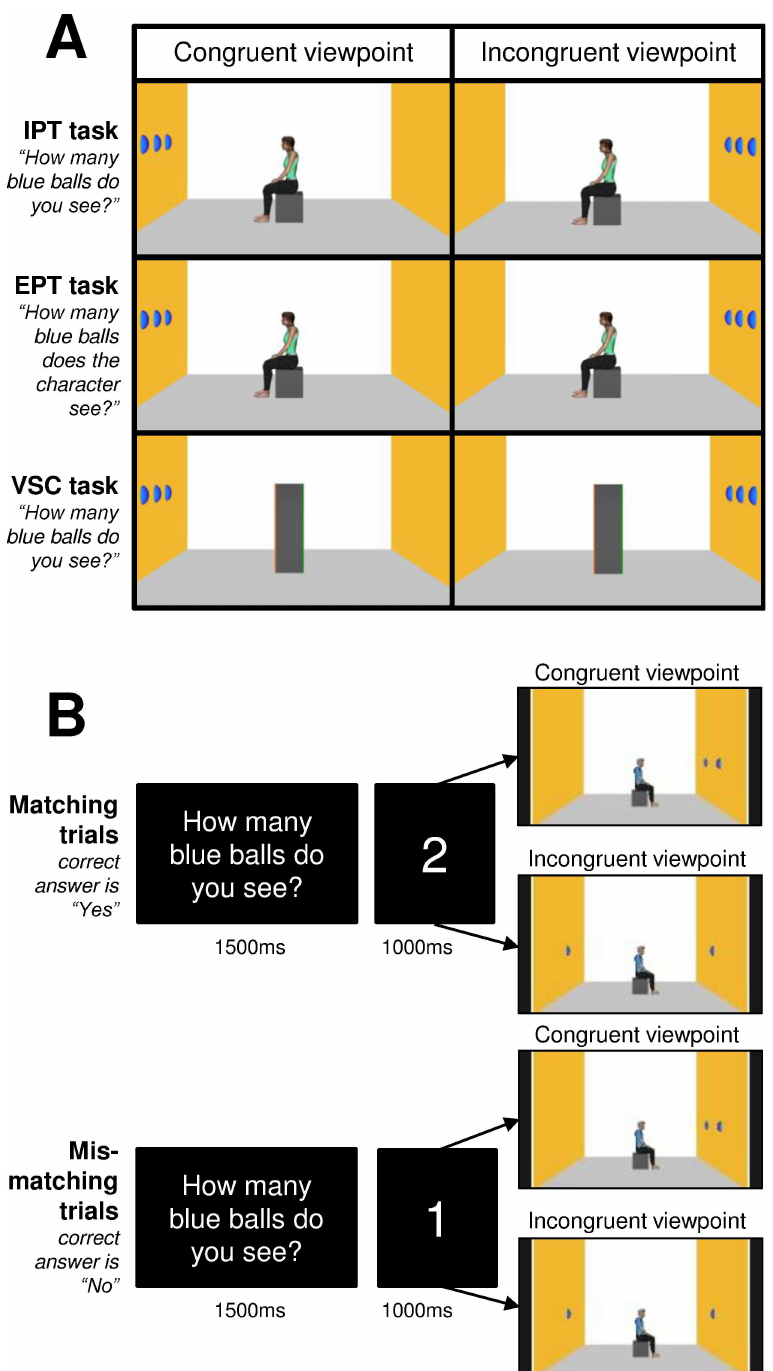
Fig 1. Methods for visuo-spatial perspective-taking tasks (Experiment 1). (A) Examplesof visual stimuli used for the tasks of implicit perspectivetaking (IPT), explicit perspectivetaking (EPT) task, and visuo-spatial control (VSC) task. Visual stimuli presenteda congruent or an incongruentviewpointof the avatar with the participant’s viewpoint.(B) Participantsindicatedwhetherthe numberof balls seen from their viewpoint(IPT and VSC tasks) matched (i.e., matchingtrials) or did not match (i.e., mismatching trials) the number presented in the